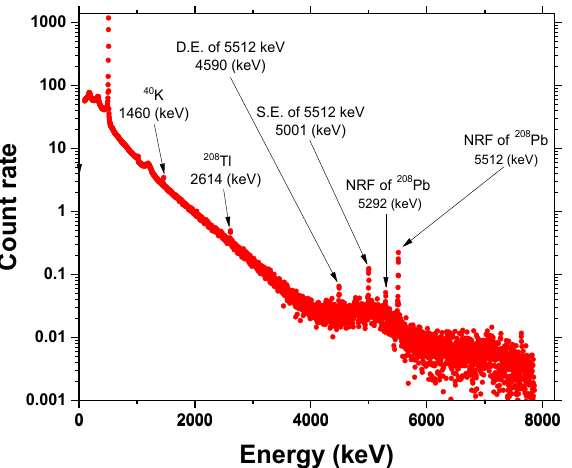
Figure 6. Typical summed spectrum of the two HPGe detectors with 2 keV rebinning.